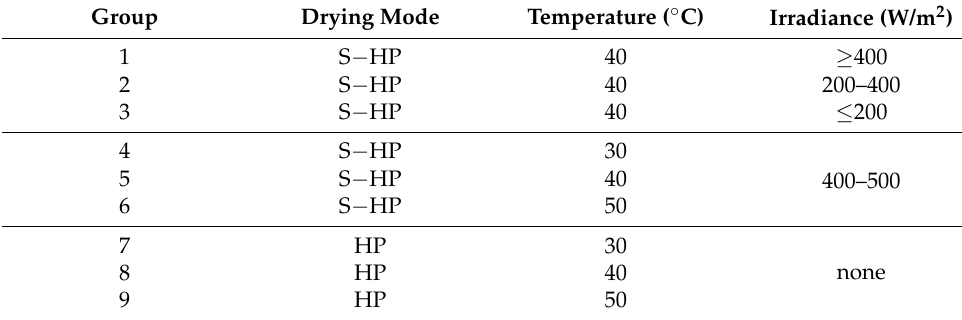
Figure 2. Photos of the proposed SHPD ( a ) and the geometric arrangement of the kelp for drying ( b ). Table 2. Arrangement of the drying tests for kelp.